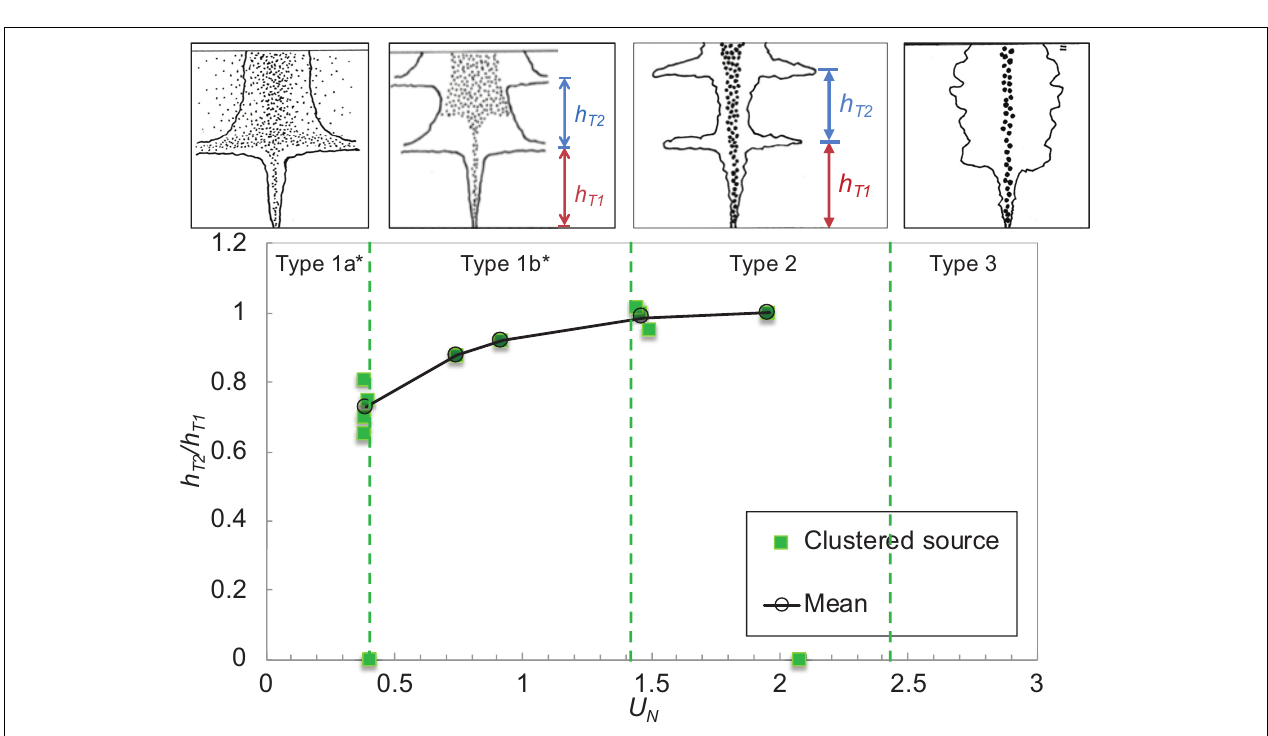
FIGURE 6 | h T 2 /h T 1 as a function of U N , showing increasing h T 2 /h T 1 with U N for clustered source (green squares) configuration. Open circles denote the mean, and the solid line represents the trend. h T 2 /h T 1 with a value of zero means no secondary intrusion was observed. Hence secondary intrusion was only observable for a range of U N . The plume types indicated on top of the figure (top four panels) are consistent with Figure 3 .